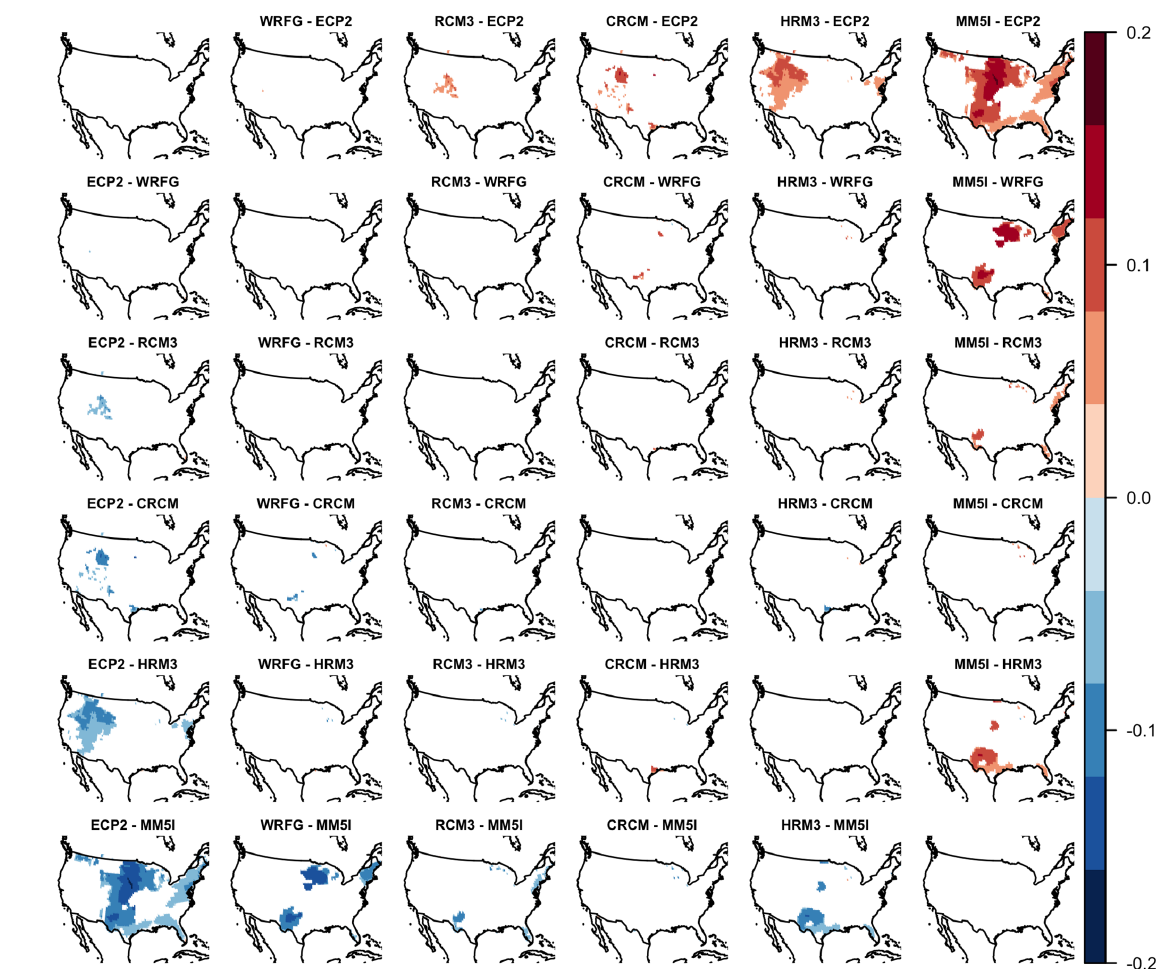
Figure 13. A heat map of the estimated average pairwise difference in rate of temperature change for RCM effects for the ASL model. Only significant locations at the 0.10 level using the CoPE method are shown.